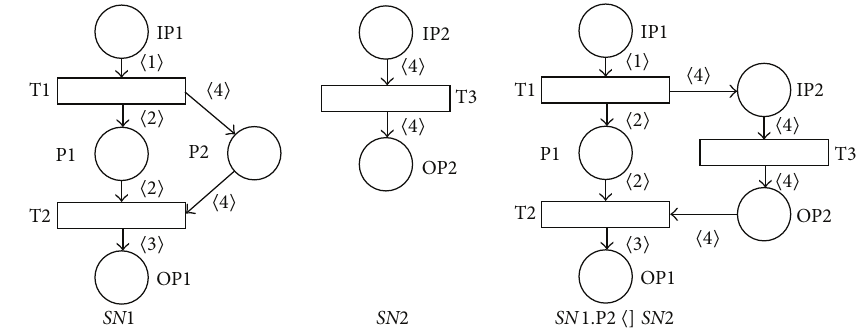
Figure 6: Result of place-substitution operation 𝑆𝑁1. P2 ⟨] 𝑆𝑁2